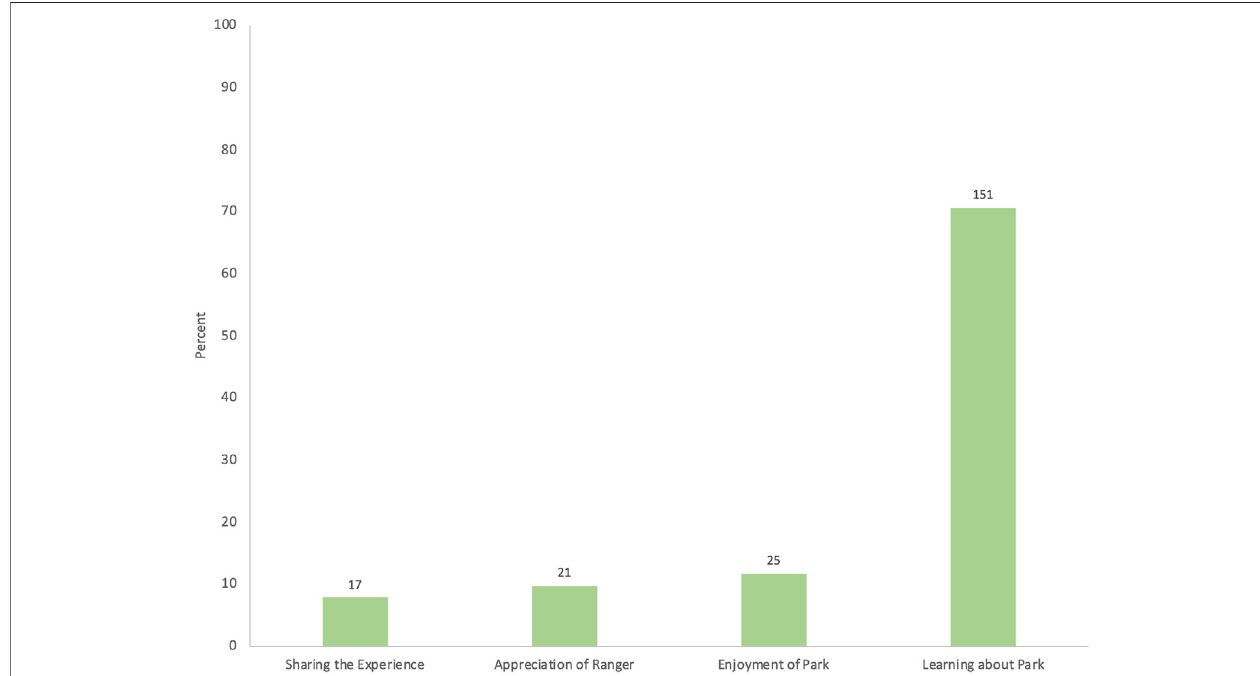
FIGURE 3 | Impacts of hike recalled by visitors ( n (cid:1) 214).